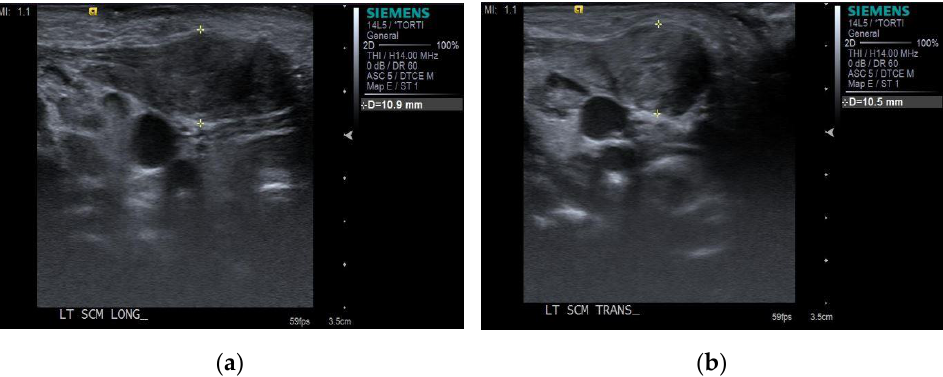
Figure 2. The thickness of the SCM muscle was measured with electronic calipers in ( a ) the longitu- dinal plane and ( b ) in the transverse plane.